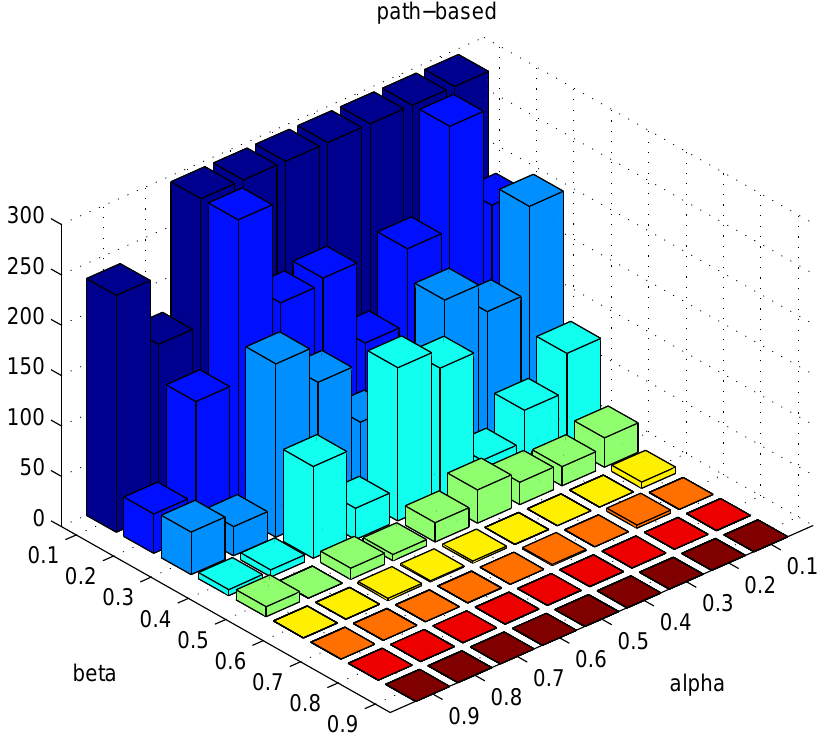
Figure 19. Number of “bad data points” found under different α and β combinations in the “path-based”